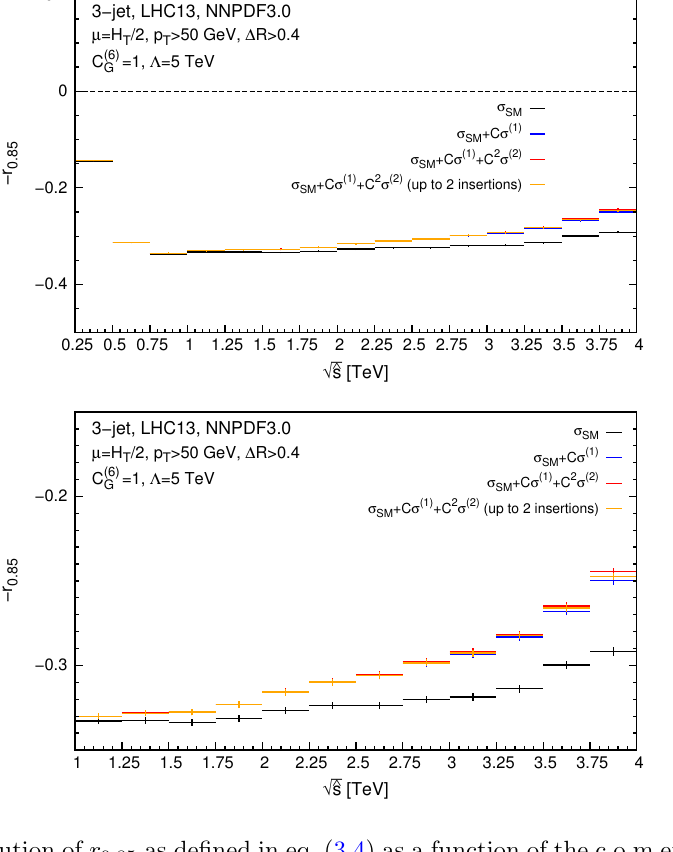
Figure 16 . Distribution of r 0 : 85 as de(cid:12)ned in eq. (3.4) as a function of the c.o.m energy in three-jet production at LHC13 with the cuts de(cid:12)ned eq. (3.2). The lower plot zooms in the high-energy region of the upper